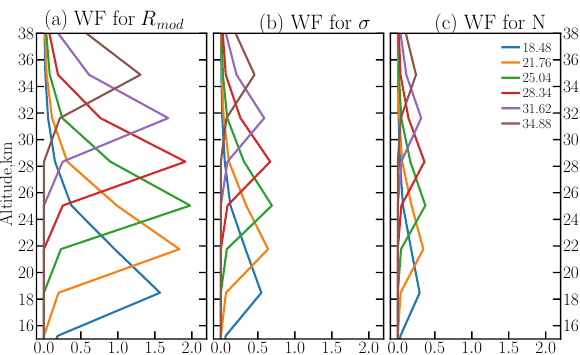
Figure 2. Relative logarithmic weighting functions at λ 7 = 1530nm in the retrieval height range for R mod (a) , σ (b) , and particle number density N (c) . The different tangent heights are colour